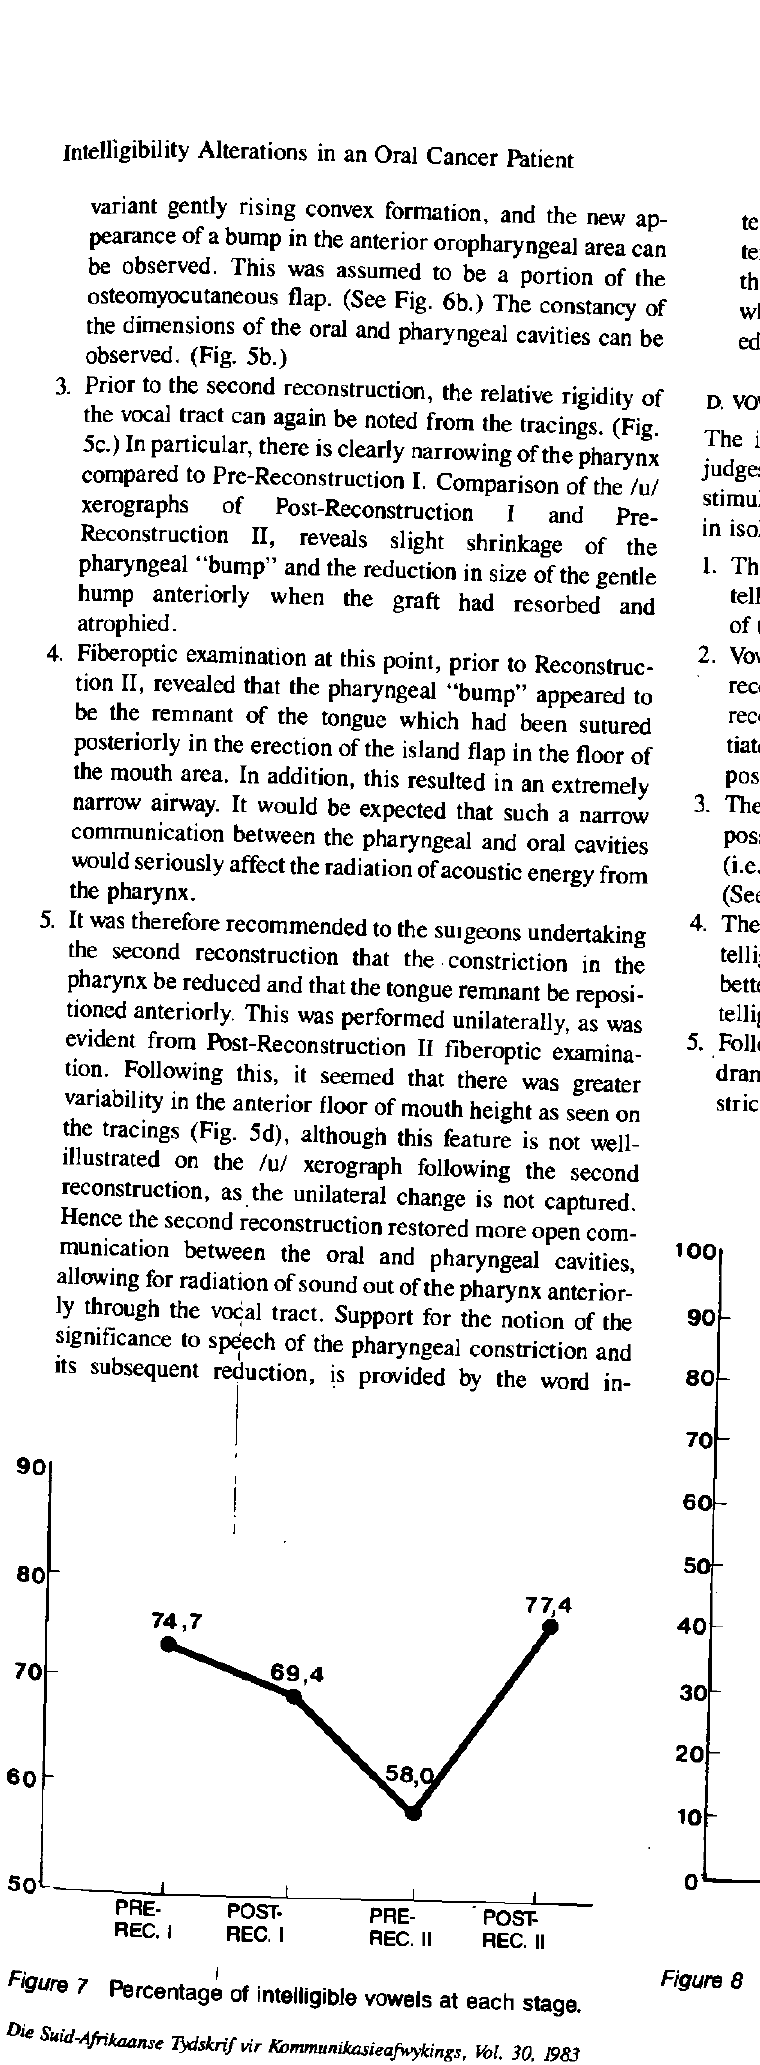
Figure 7 Percentage of intelligible vowels at each stage. D le Swd-Afrikaanse Tydskrif vir Kommunikasieafwykings, Vol. 30, 1983